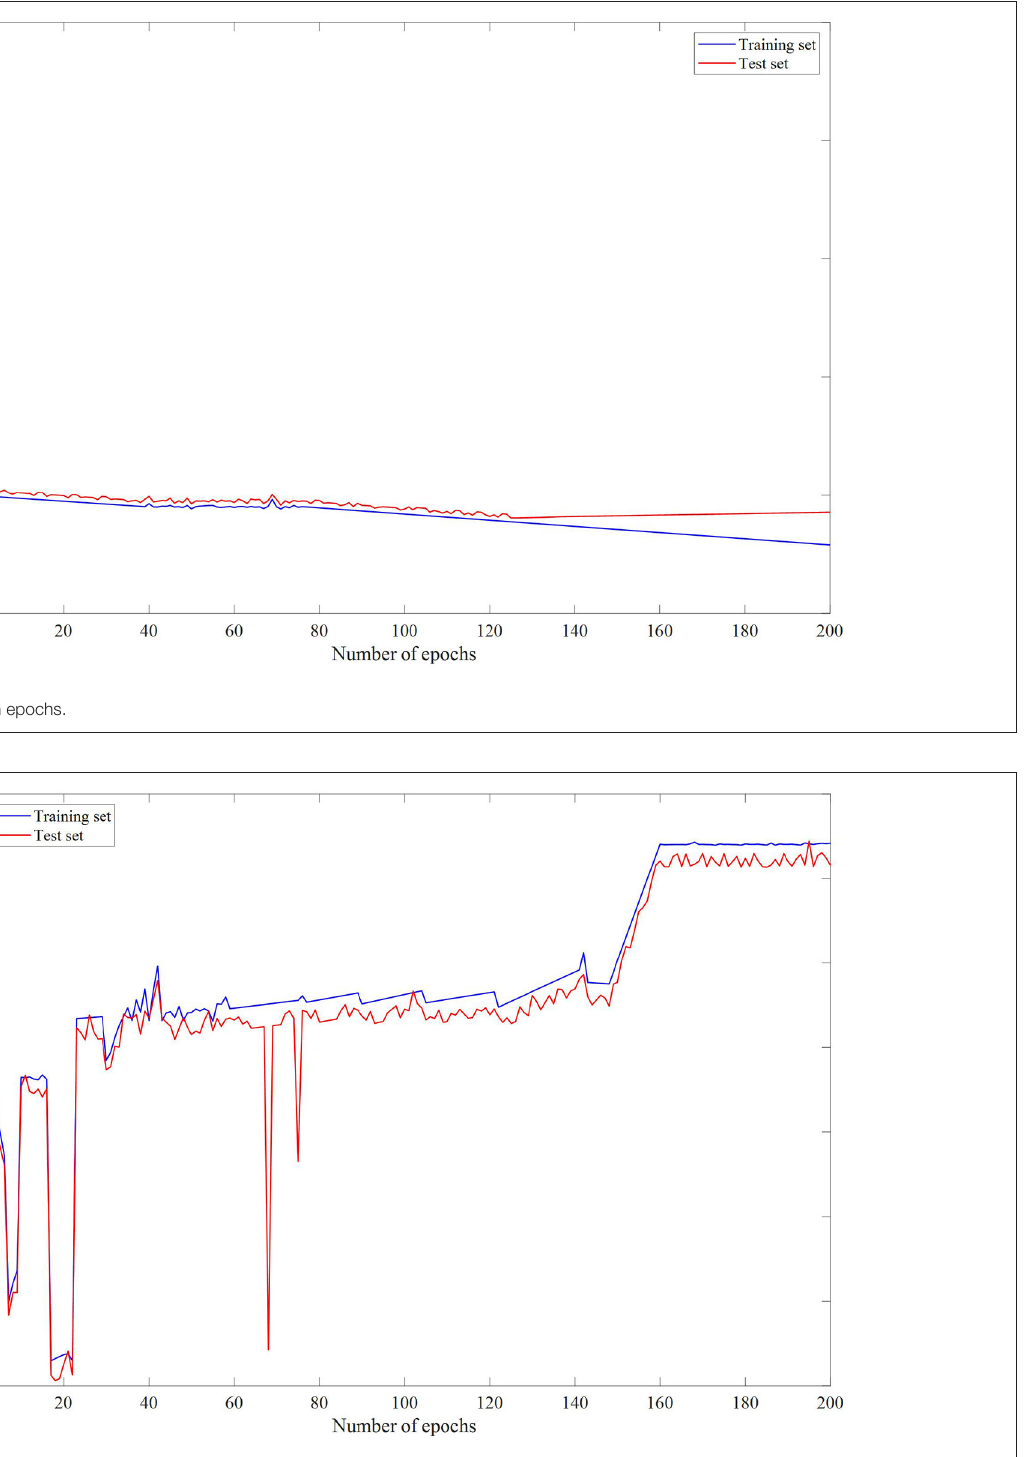
FIGURE 3 | F1 changes with